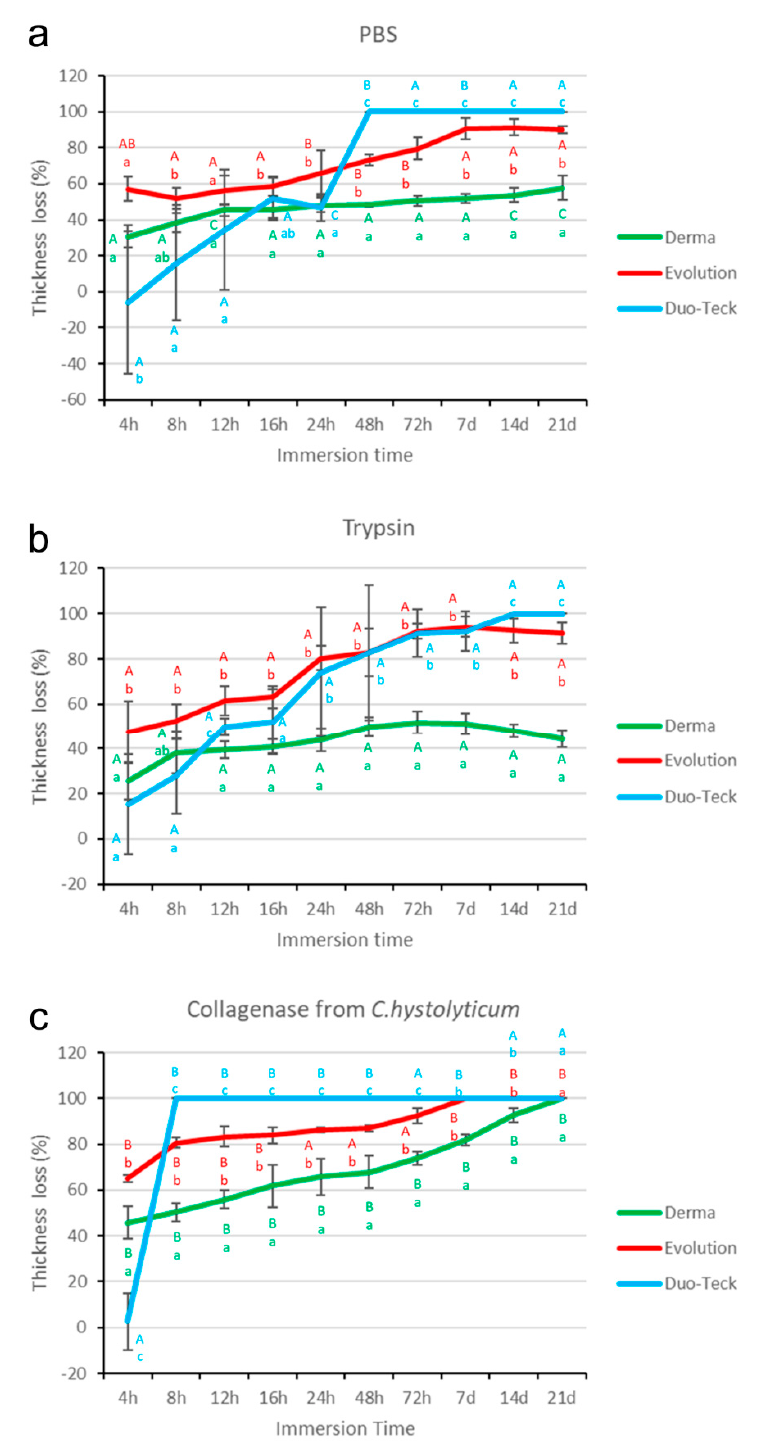
Figure 1. Degradation profile by % thickness loss analysis of the three experimental membranes (Derma Fina, Evolution Standard and Duo-Teck) over immersions periods up to 21 days in: ( a ) PBS, ( b ) trypsin and ( c ) collagenase from Clostridium histolyticum . Values shown are mean and standard deviation ( n = 3). Significant di ff erences between membranes within the same immersion solution are noted by low-case letters. Di ff erences between di ff erent immersion solutions within the same membrane are pointed out with capital letters. Multiple comparisons were performed by Student-Newman-Keuls ( p < 0.05).